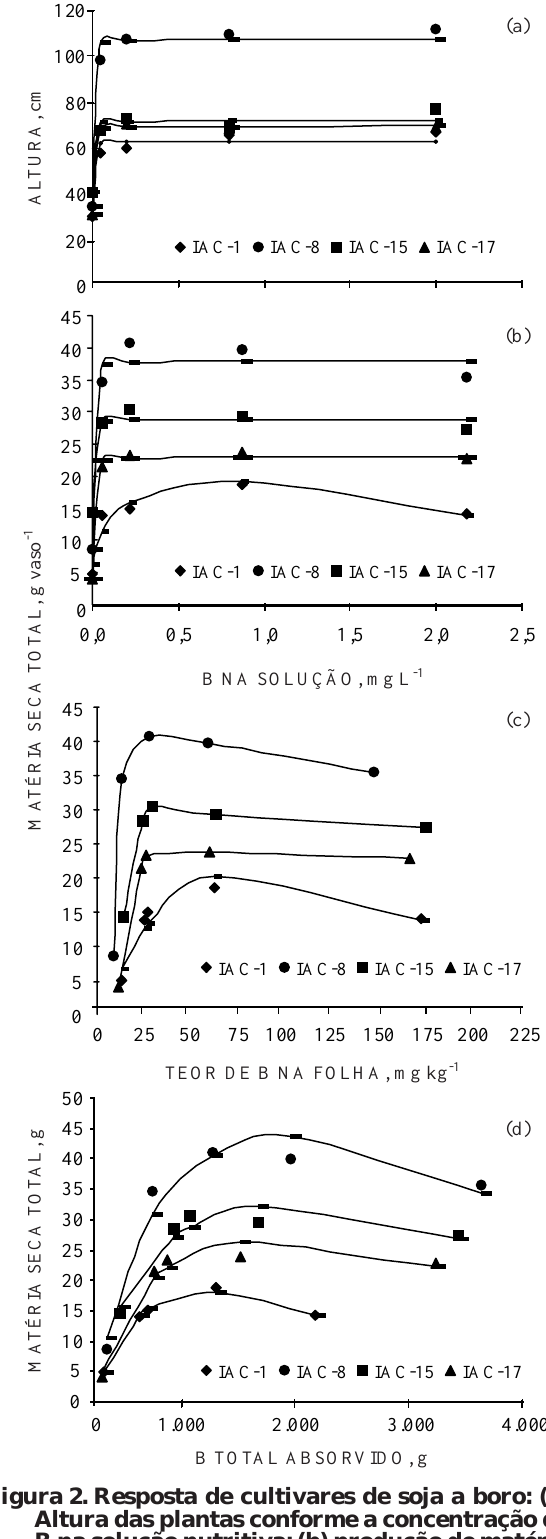
Figura 2. Resposta de cultivares de soja a boro: (a) Altura das plantas conforme a concentração de B na solução nutritiva; (b) produção de matéria seca total conforme a concentração de B na solução nutritiva; (c) relação entre produção de matéria seca total e teores de B nas folhas; (d) relação entre matéria seca total e conteúdo total de B nas